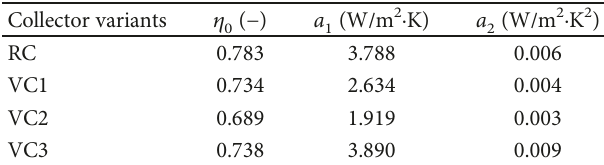
Table 2: Summary of the collector simulation results.